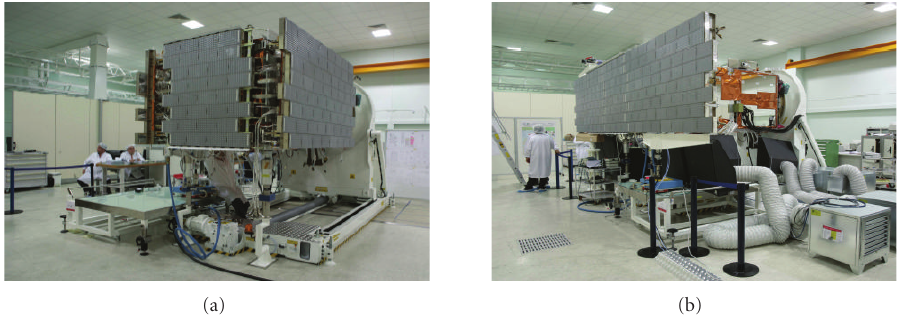
Figure 2: COSMO sky med active SAR antenna (stowed & deployed).